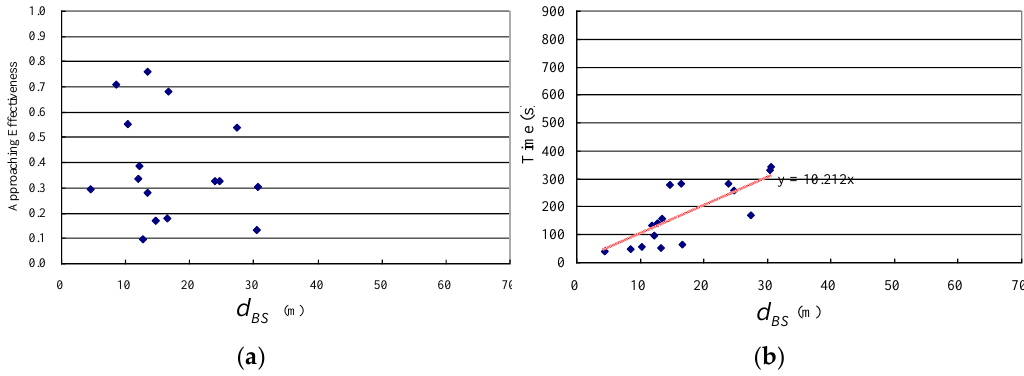
Figure 14. Results of 16 ERP experiments in the O group. ( a ) Approaching effectiveness. ( b ) Time cost. Each mark in the two subgraphs stands for the corresponding value of an experiment.